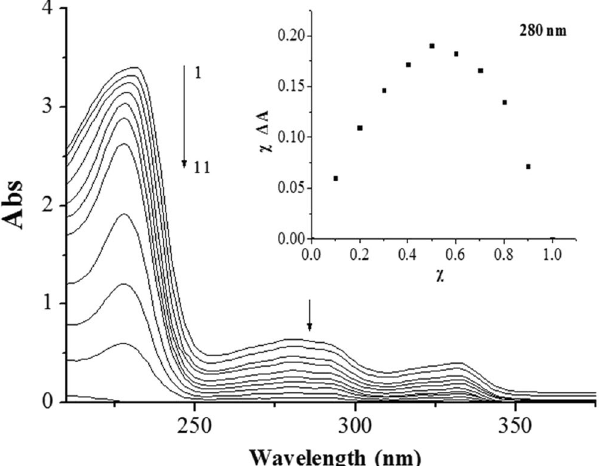
Figure 11. UV/vis absorption spectra of 5 (6.0 × 10 − 5 mol/L) in CH 3 CN at 25 °C. The concentrations of H 2 PO 4 − for curves 1–11 (from bottom to top) are: 0, 0.6, 1.2, 1.8, 2.4, 3.0, 3.6, 4.2, 4.8, 5.4, 6.0 × 10 − 5 mol/L. Inset: The Job’s plot for 5 ·H 2 PO 4 − complex in CH 3 CN at 280